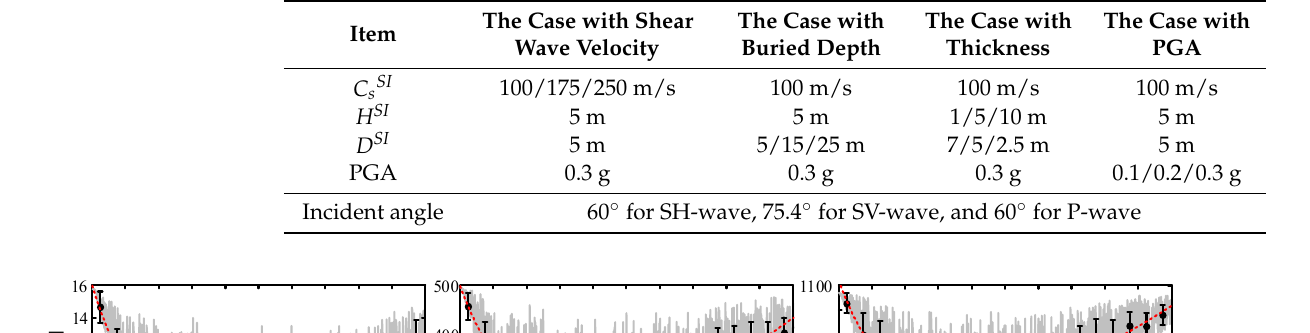
Table 2. Study cases performed.